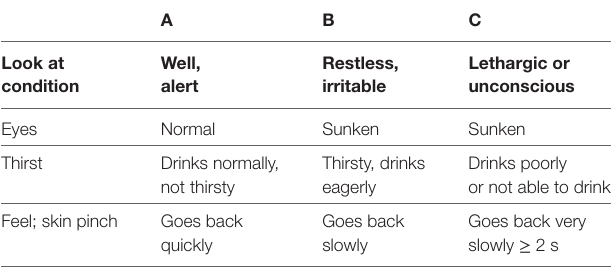
≥ 3 clinical signs ≥ 5% body weight from